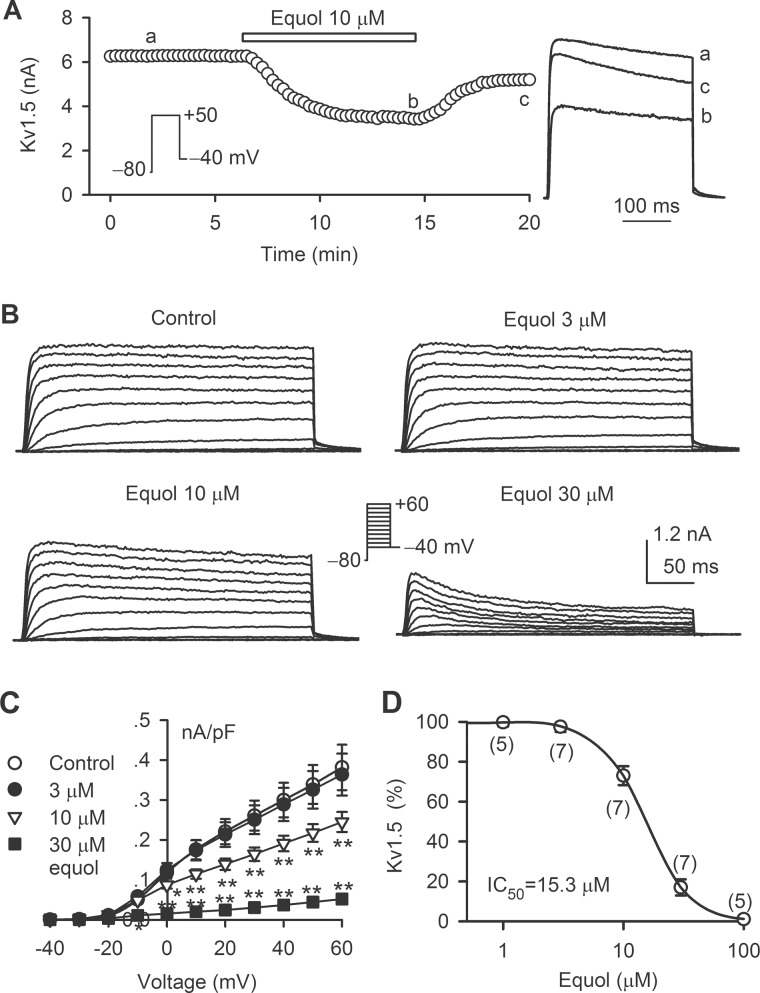
Effect of equol on hKv1.5 current.(A) Time course of hKv1.5 current recorded in a representative HEK 293 cell stably expressing KCNA5 in the absence and presence of 10 μM equol. Original current traces at corresponding time points are shown in the right. (B) Voltage-dependent hKv1.5 current recorded in a typical experiment in control and in the presence of 3, 10 and 30 μM equol. (C) I-V relationships of hKv1.5 current in the absence and presence of 3, 10 and 30 μM equol (n = 7, *P<0.05, **P<0.01 vs. control). (D) Concentration-response relationship for inhibiting hKv1.5 current by equol at +50 mV. The data were fitted to the Hill equation: E = Emax/[1+(IC50/C)b], where E is the inhibition of current in percentage at concentration C, Emax is the maximum inhibition, IC50 is the concentration for 50% of maximum inhibition effect, and b is the Hill coefficient. The numbers in the parentheses represent experimental number.